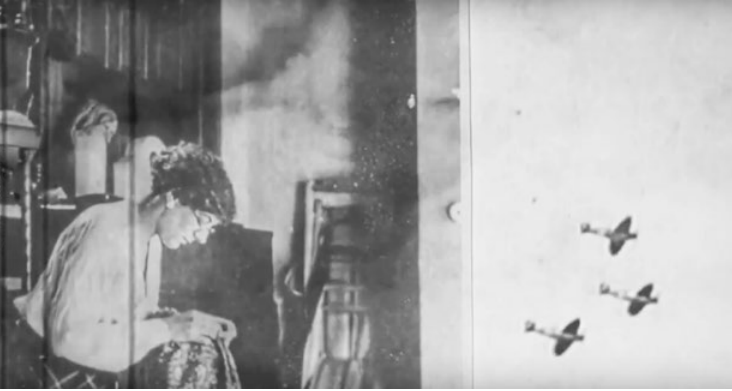
Figure 8.10 Screengrab from Canticle : STW and planes